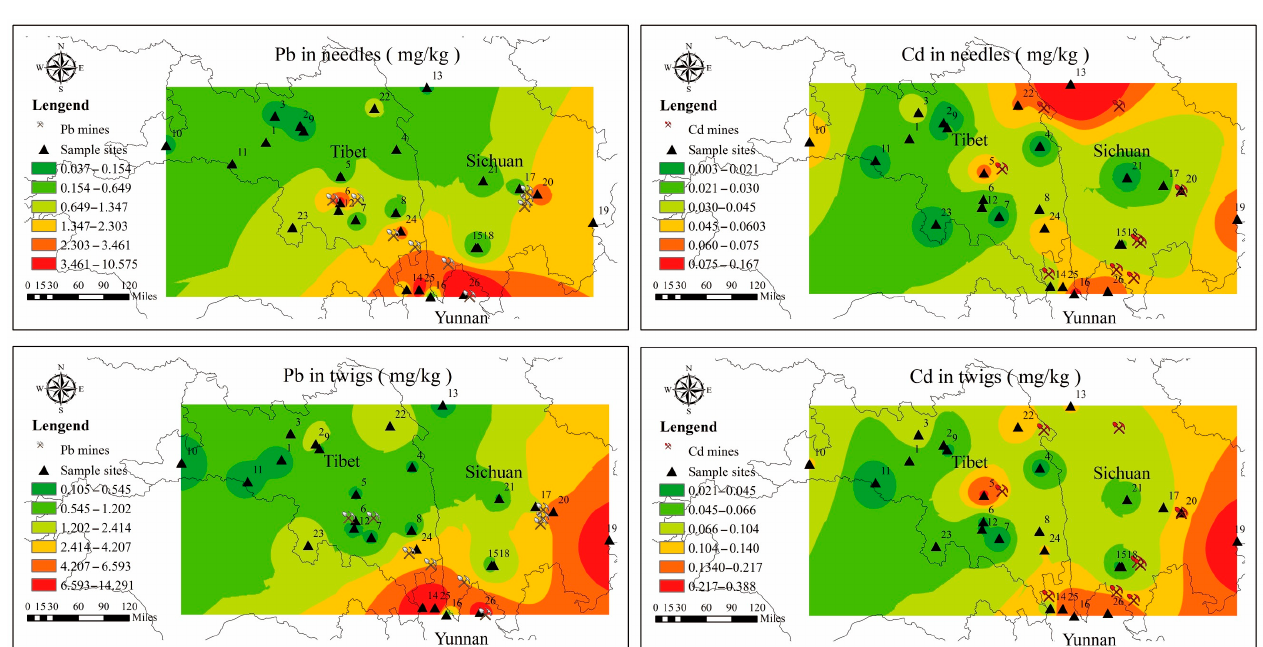
Figure 2. Spatial distribution map of Pb and Cd in the needles and twigs in the mining area close to our study area (https://www.sohu.com/a/365087860_660942). The red and orange colors on each small map represent relatively high concentration of Pb and Cd, while the green and lime colors represent relatively low concentrations, respectively. The buff color represents the middle values.